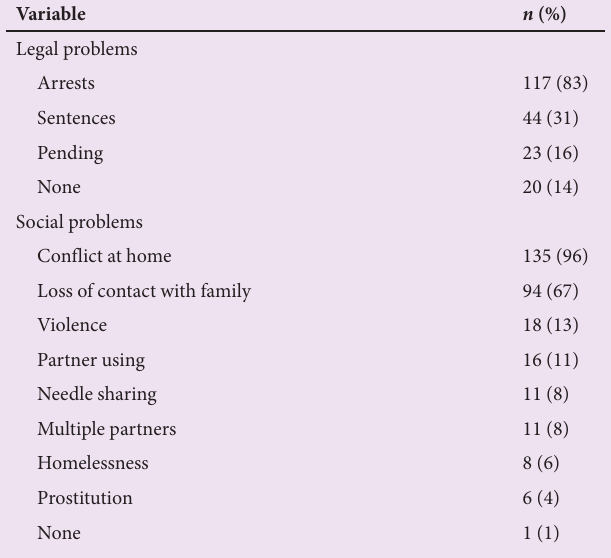
Table 5. Frequency of legal and social repercussions in the sample ( N =141)